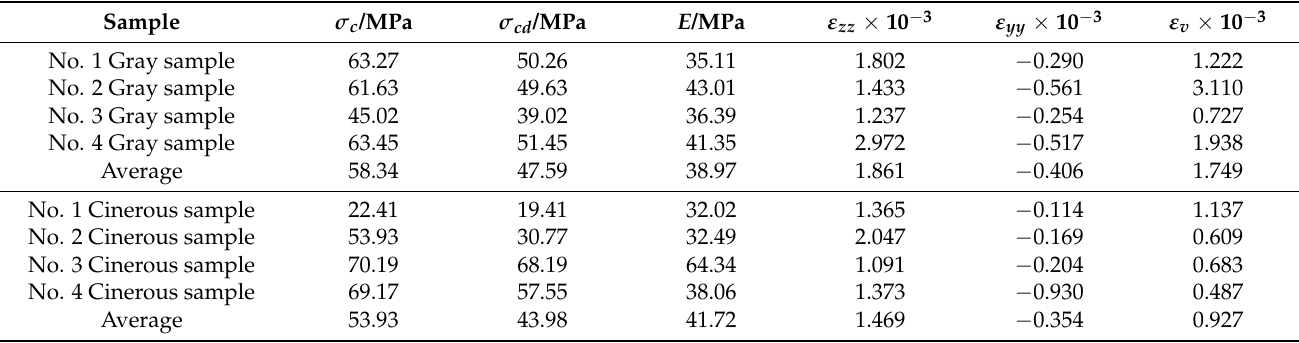
Figure 5. Stress − strain curves under parallel loading: ( a ) Gray samples; ( b ) Cinerous samples. The initial compaction stage (stage I) shows that the axial deformations for both vertical loading and parallel loading are similar. When the vertical stress was loaded, the slate sample was compacted by a small load due to many micropores among the weak surface structures. The vertically superimposed slate rock had a rock pillar effect during parallel loading [17]. The strength of natural slate is noticeably greater than the strength of bedding cementation. The superimposed slate rock may only undergo axial compression and an adjustment of the alignment of mineral bundles due to a small axial loading, but not show a significant compaction process similar to that due to vertical loading. The slate samples enter the elastic deformation stage (stage II) after the completion of existing micro-fractures and cementation compaction with further loading of axial stress. Thereafter, the integral rigidity increases and the stress-strain curve increases approximately linearly. The gray and cinerous samples show linear deformation when the load is perpendicular to the weak surface structures; axial compression controls the overall deformation, and the axial deformation is about 1.50 to 2.50 times that of hoop deformation, as shown in Figure 4. The rock pillar formed by superimposition is sufficient to support the axial load when the load is parallel to weak surface structures; the relative axial strain of gray slate and cinerous slate is smaller than the vertical loading condition, as shown in Figure 5. Tables 1 and 2 show that the average elastic modulus of the cinerous samples is significantly greater than that of the gray samples for both vertical and parallel loading. This is because the weak surfaces of the slate rock layers and main stresses are related in series during vertical loading, and slate rock is dominated by compression deformation while hoop deformation is constrained. Table 1. Mechanical parameters for vertical